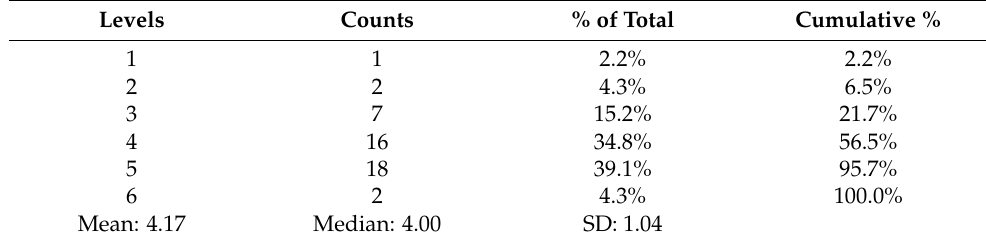
Table 5. Total Score.